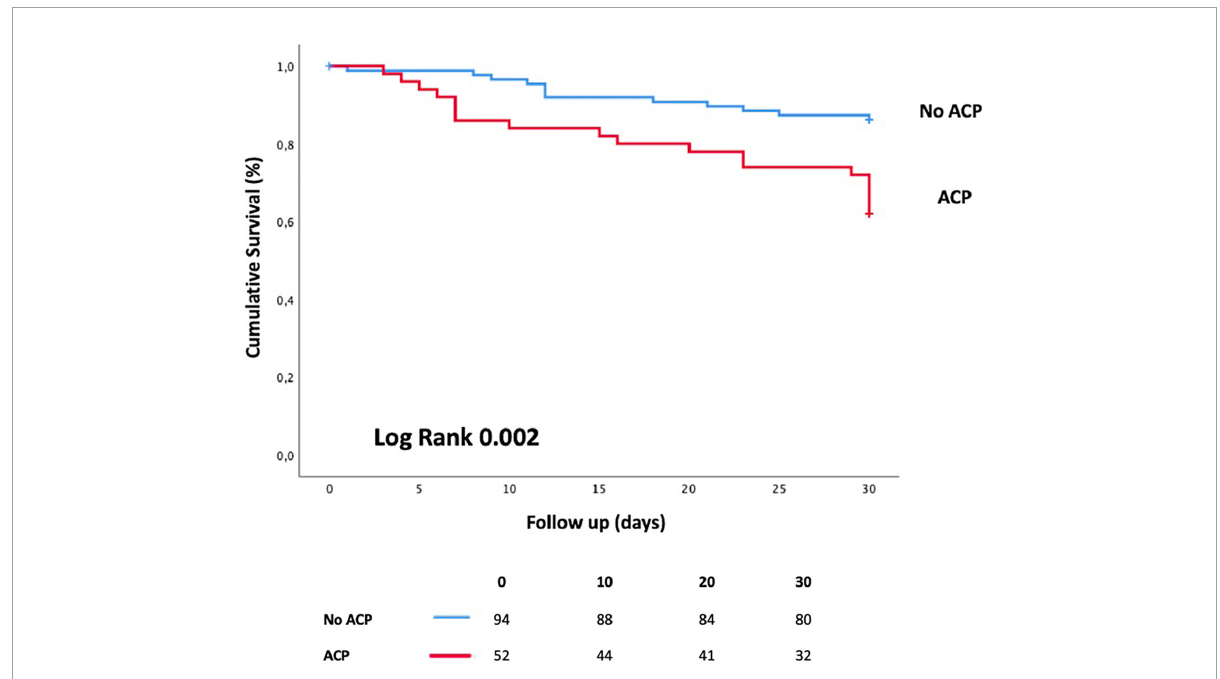
FIGURE2 Kaplan–Meier curves showing event-free survival according to the presence of acute cor pulmonale. ACP, acute cor pulmonale.